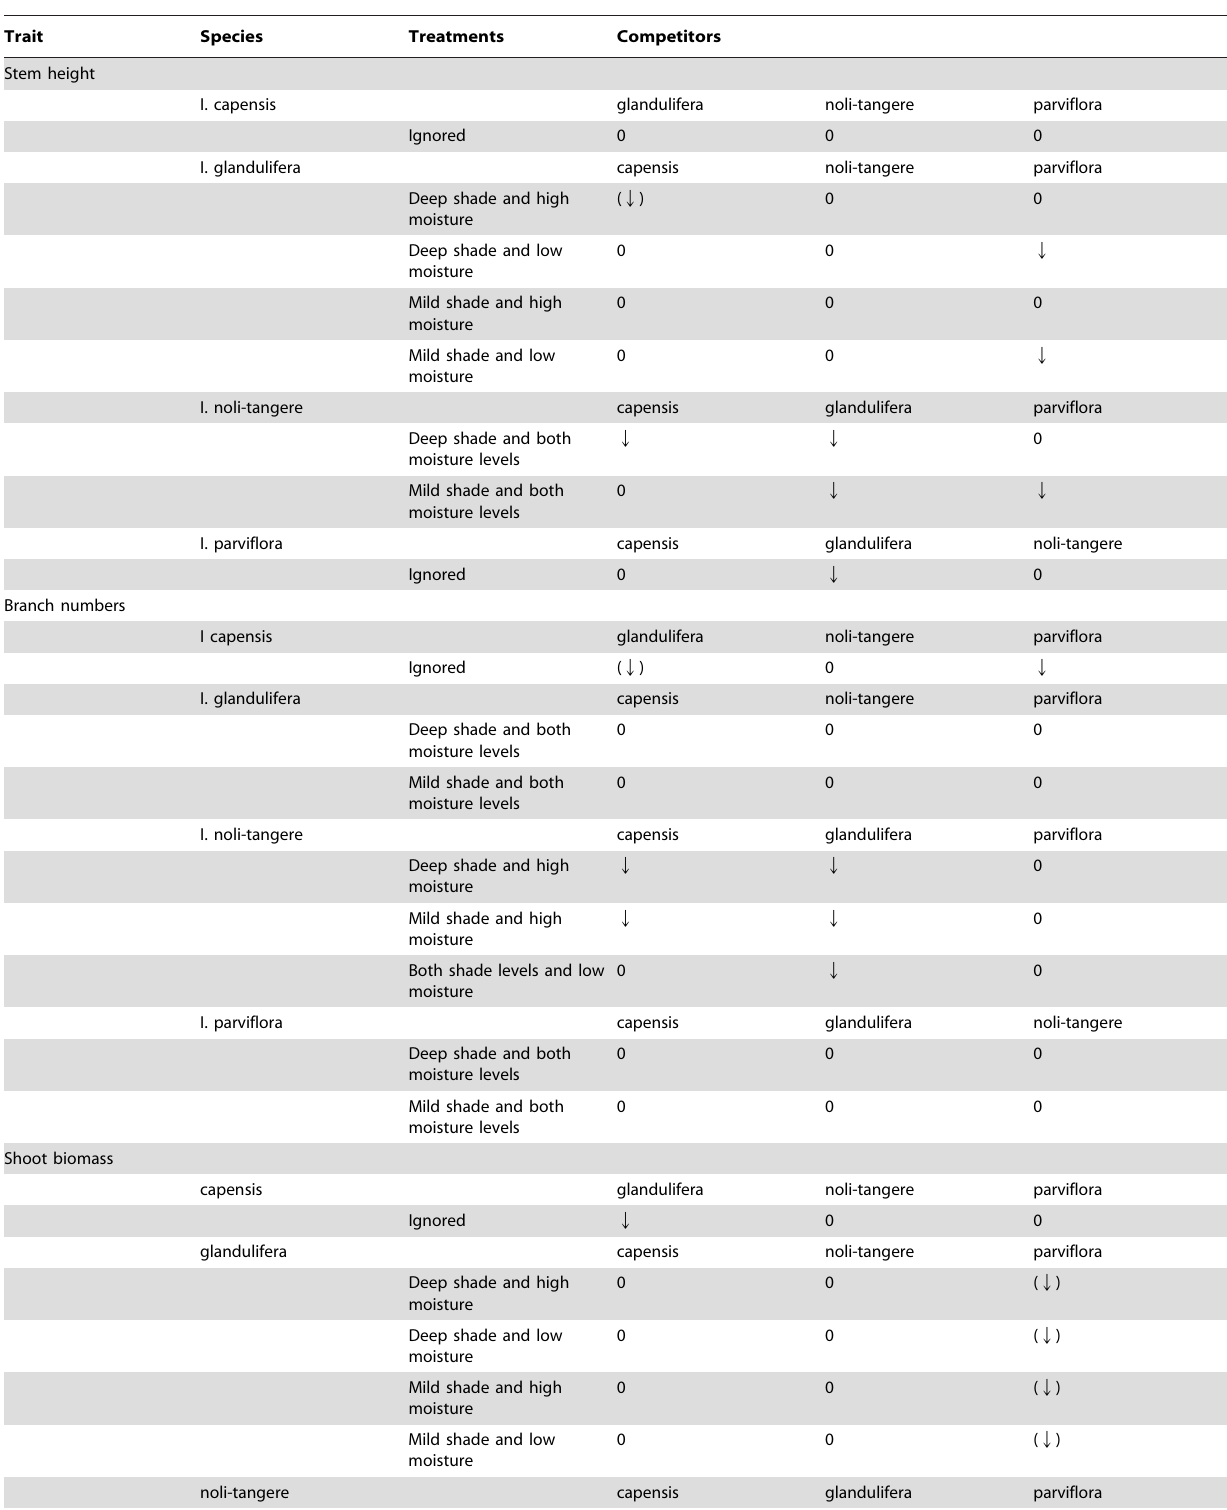
Table 1. Summary of comparisons of species traits (Stem height, Branch numbers and Shoot biomass) in the second experiment with four Impatiens species ( I. capensis , I. glandulifera , I. noli-tangere , I. parviflora ) under four environmental treatments (Deep/Mild shade and high/low